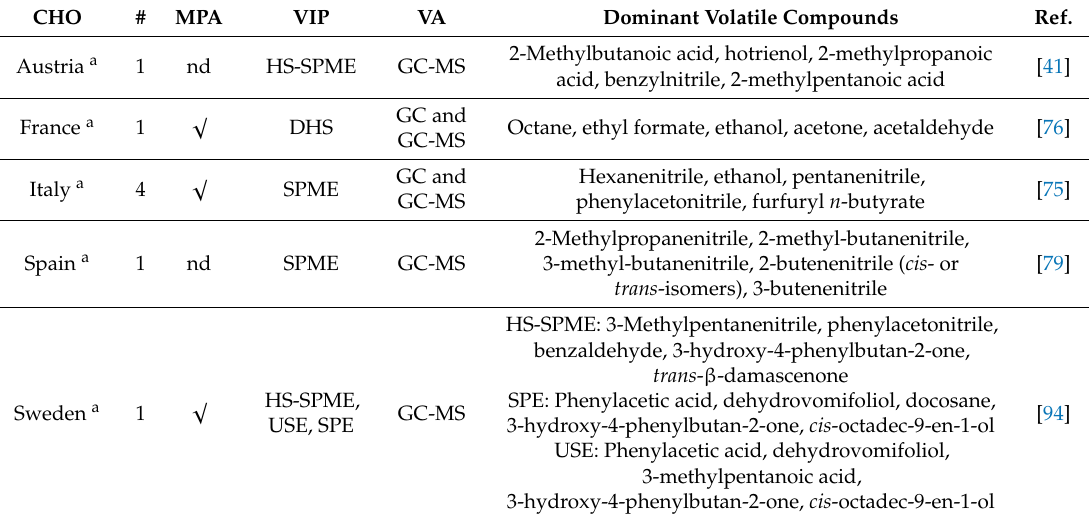
Table 7. Dandelion honey’s main volatiles, with reference to the country of origin, number of samples, isolation and analysis procedures and five main volatile components. Unless otherwise specified, the honeybee type was A. mellifera